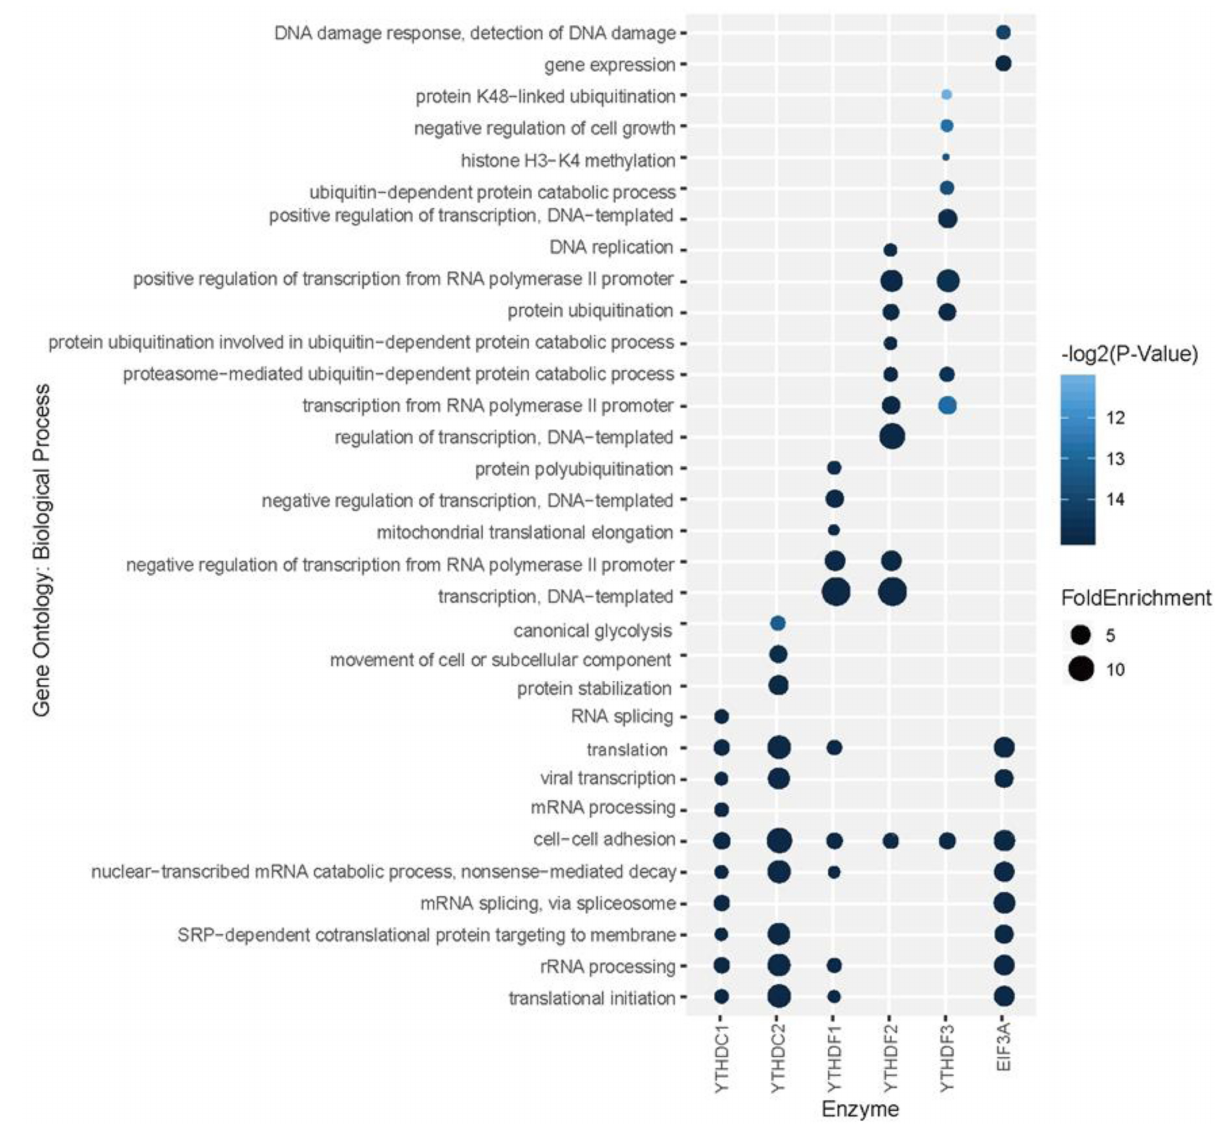
Frontiers in Cell and Developmental Biology |